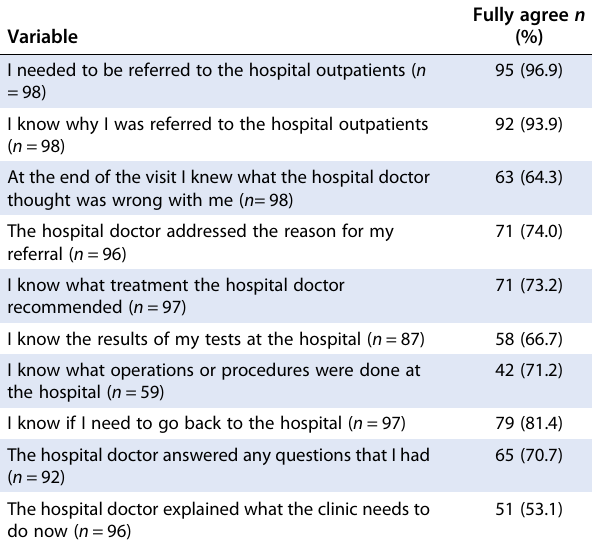
Table 8: Agreement of patients with statements regarding key aspects of their OPD visit Variable